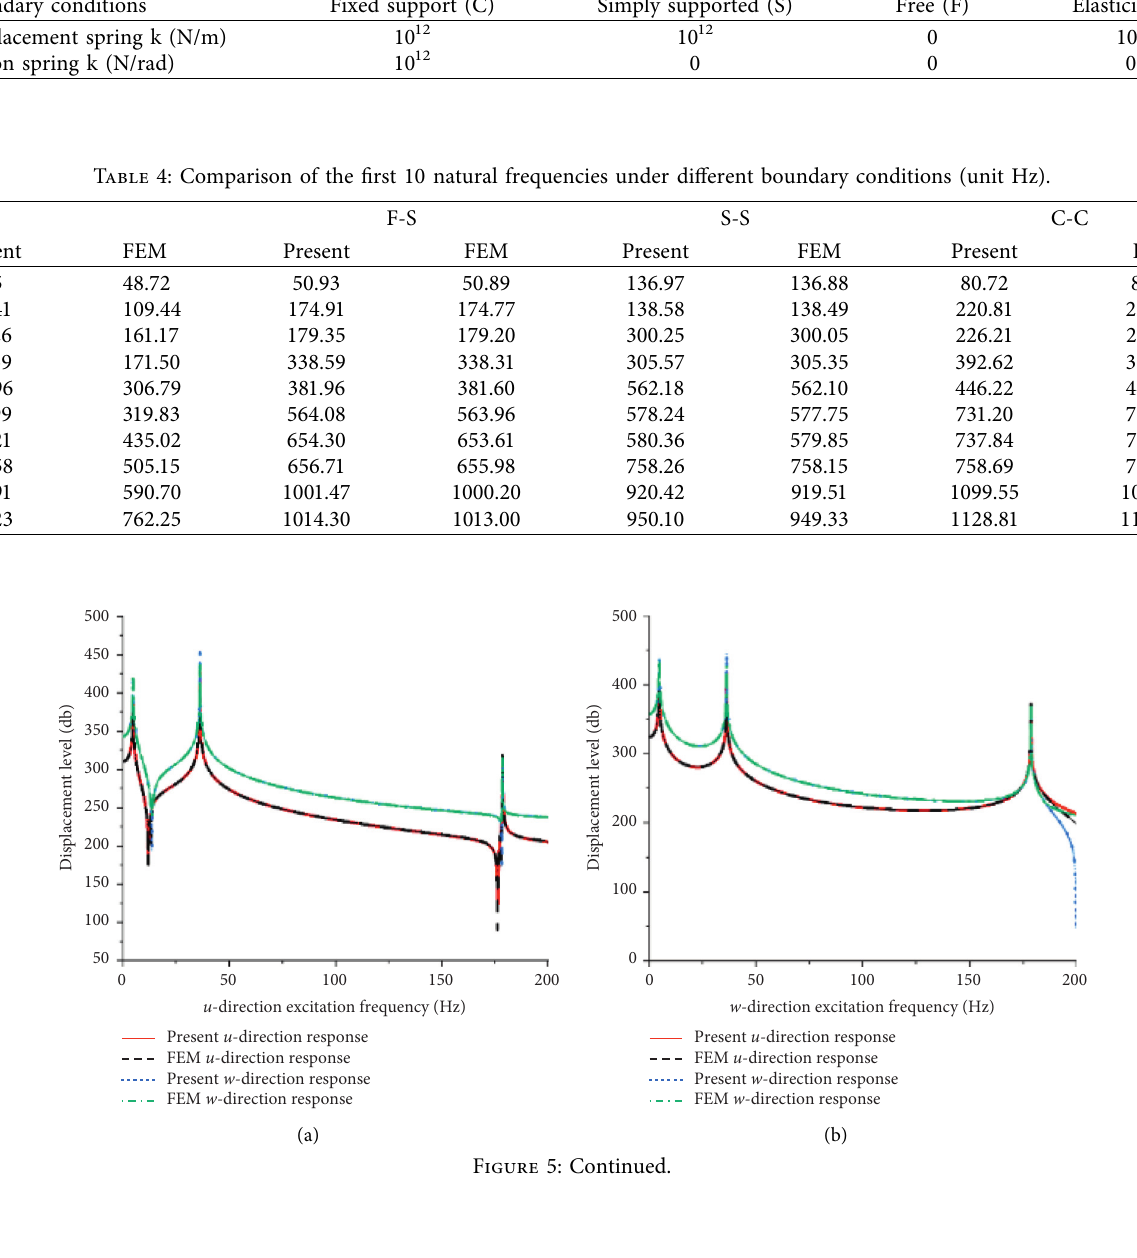
Table 3: Value table of various boundary conditions of spring simulation. Boundary conditions Fixed support (C) Displacement spring k (N/m) Ration spring k (N/rad)